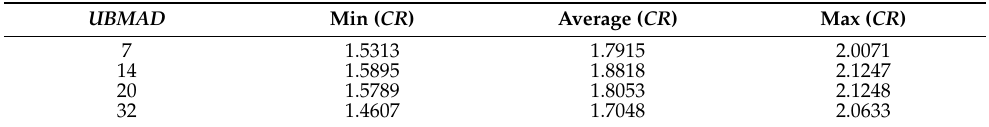
Table 4. Dependence of the minimum, maximum, and average values of CR on UBMAD for the case of DAT2 of depth 2.